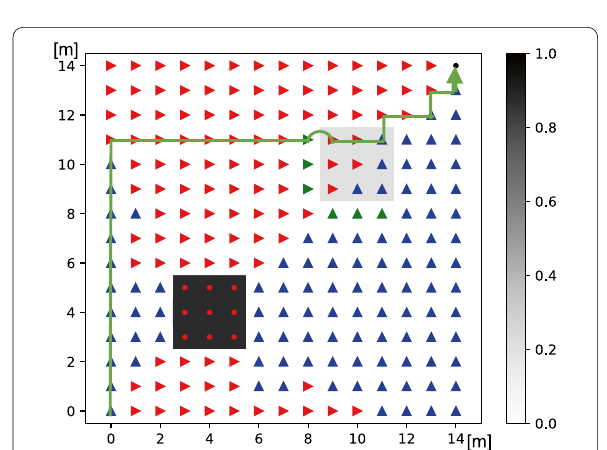
Fig. 11 The environment for the vertical hopping simulation. The tall rock is shown as dark grey, and the low rock is shown as light grey. The vertical hopping actions are plotted as green arrows. The path includes the vertical hopping shown as a green